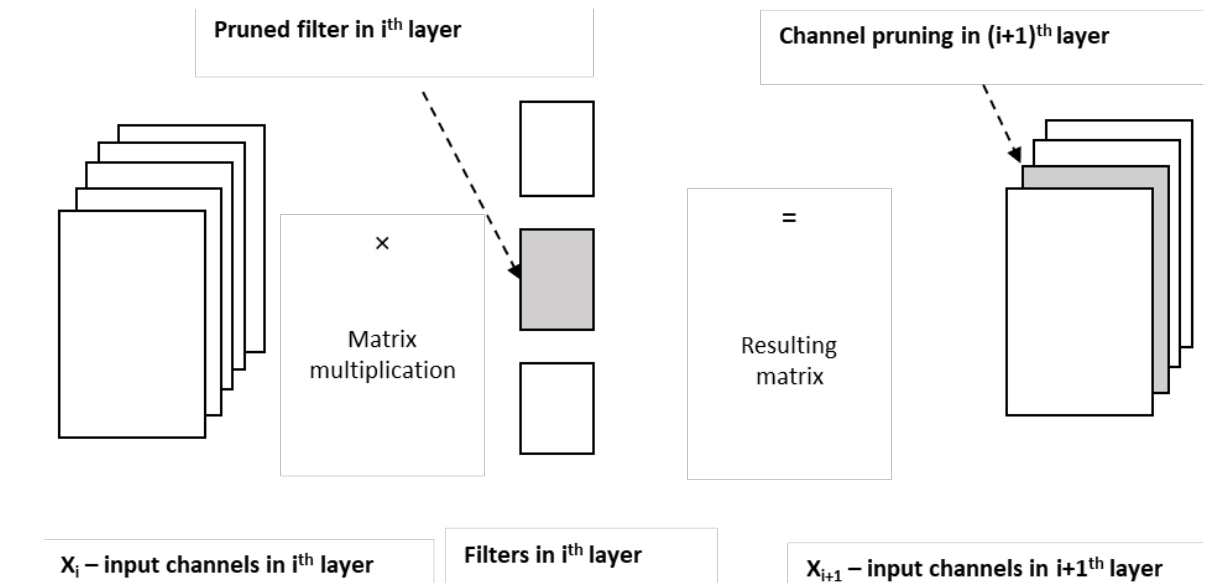
Figure 12. Filter and channel pruning.